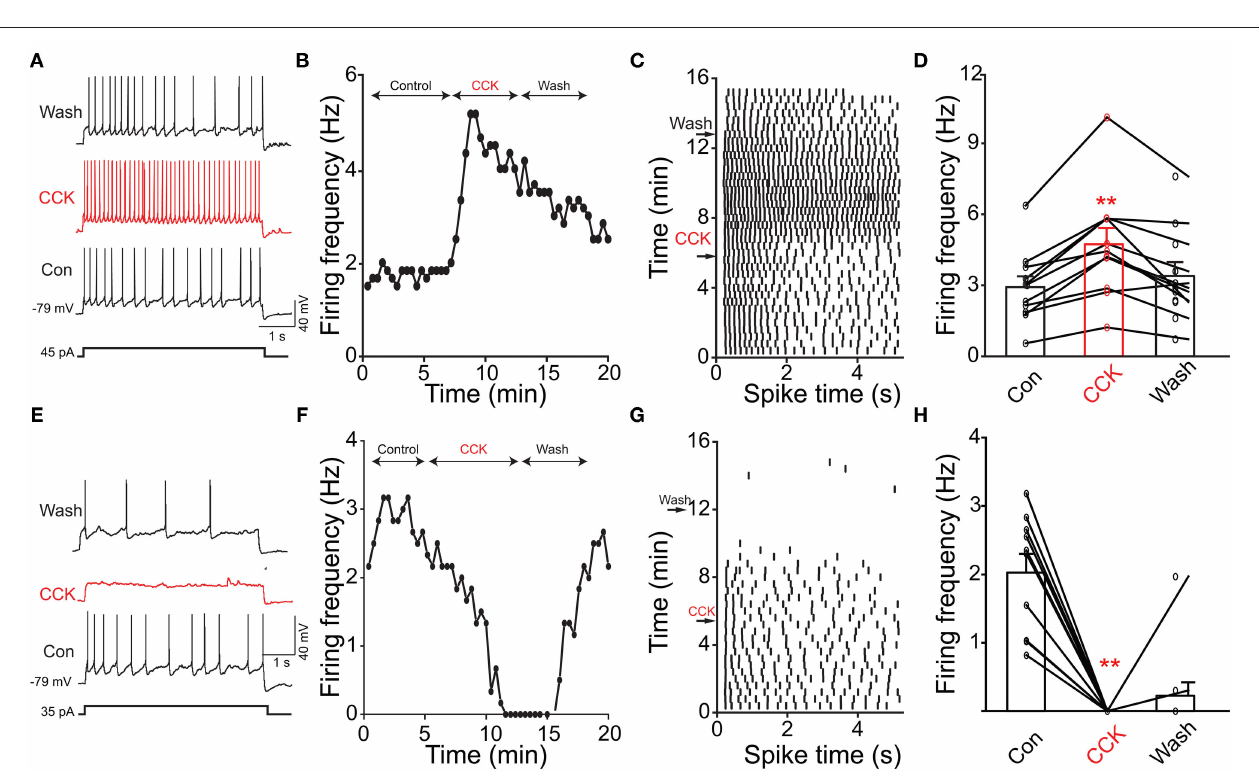
FIGURE 7 | Cholecystokinin (CCK) evoked increased or decreased excitability of PPG neurons. (A) Representative action potentials elicited under baseline (Con), neuromodulator (CCK), and washout (Wash) conditions. (B) Line graph of the recording in A where AP firing frequency vs. time of the recording is plotted. (C) Example raster plot of the cell in (A,B) . (D) Bar/line graph of the mean spike frequency changes for 11 sampled PPG neurons. **Significantly-different from baseline and wash, one-way RM ANOVA with Tukey’s post-hoc test, p < 0.01. (E–H) Same as top panels but for 10 sampled PPG neurons that were inhibited by CCK.